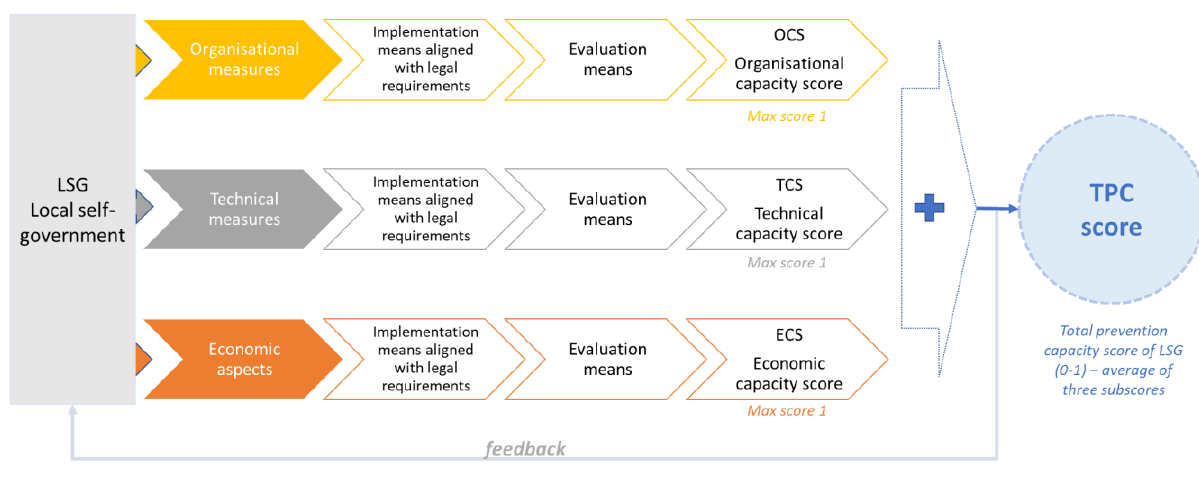
Figure 7: Prevention Capacity Building Module Components for Assessment of Organizational, Technical, and Economic Capacities and the Total Capacity Score (TPC) of LSGs (Source: Authors’